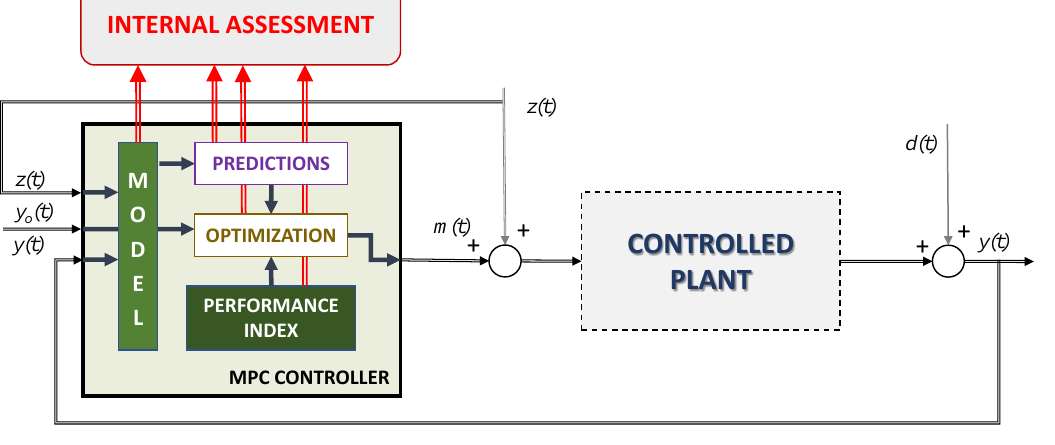
Figure 5. MPC internal approach to the CPA.